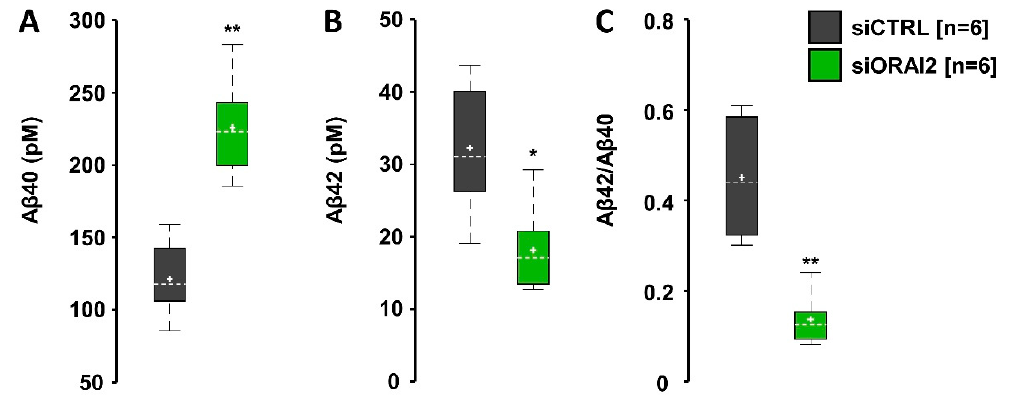
Figure 7. ORAI2 downregulation reduces A β 42 / A β 40 ratio. H4-APPswe cells were transfected with ORAI2-siRNA (siORAI2) or control-siRNA (siCTRL). Boxplots of A β 40 ( A ), A β 42 ( B ) levels and their ratio ( C ), detected in the conditioned media at 48 h ( n = number of samples, Wilcoxon-Mann-Whitney test, * p < 0.05; ** p < 0.01).